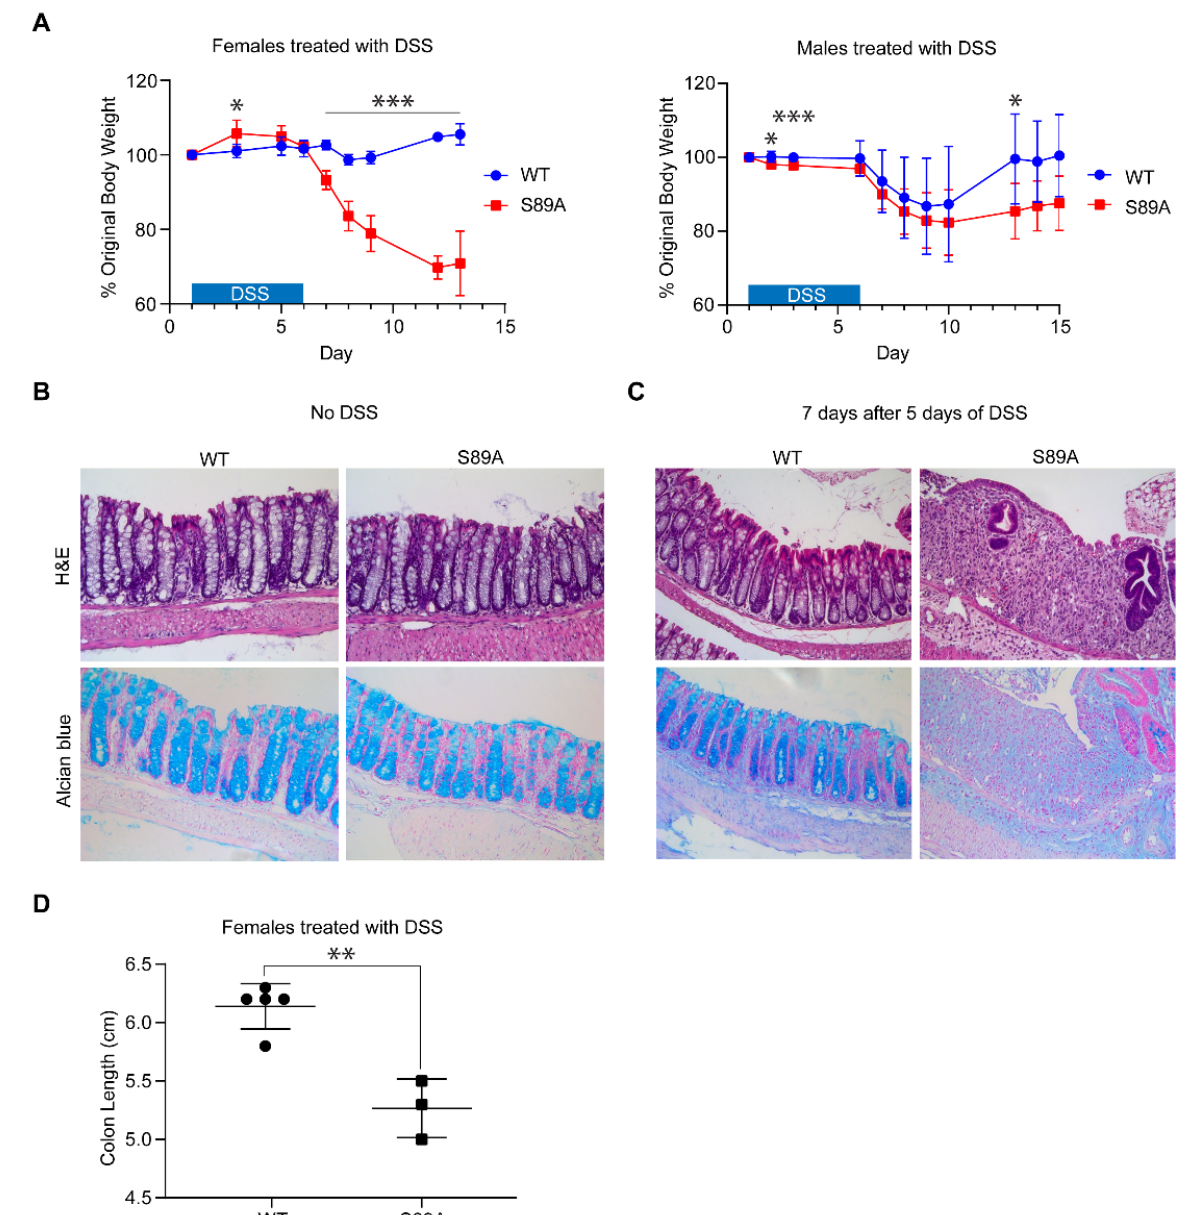
Figure 3. p300 S89A mice are extremely sensitive to intestinal insult. S89A and WT mice were treated starting on day 1 for ~5 days with low (2%) dose of dextran sodium sulfate (DSS) (or vehicle ( B ) after which treatment was discontinued for ~7 days and the effect of DSS on % original body weight ( A ), histology ( B , C ), and colon length ( D ) was assessed. Data are mean ± s.d. ( n = 3–9 per group). * p < 0.05, ** p < 0.01, *** p < 0.001. ( B ) For both WT and S89A mice without DSS treatment: H&E staining shows normal colonic mucosa. The crypt architecture is preserved and there is no evidence of acute, neu-